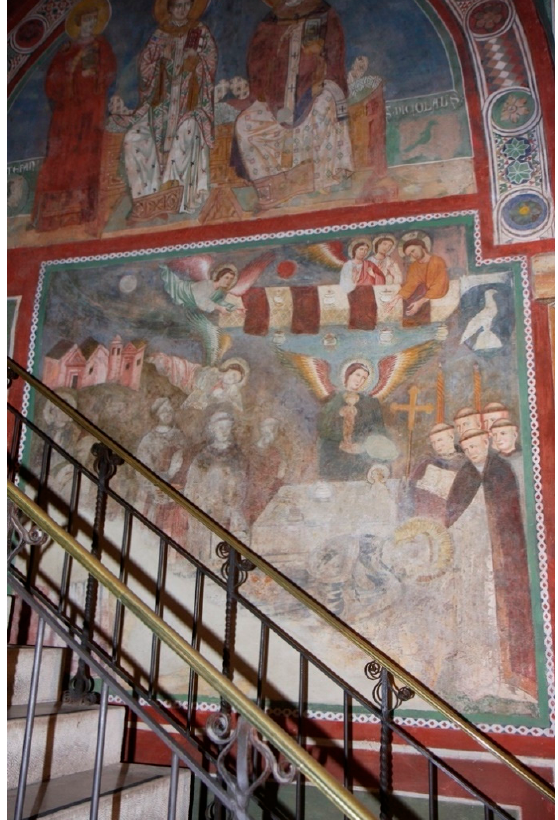
Figure 16. Sacro Speco, Subiaco (Italy), Lower Church. Fresco. Funeral of St. Benedict. Photo: Davide Giannetti.